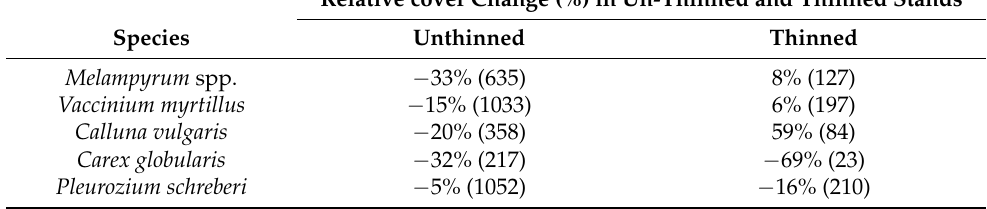
Table 4. Relative cover change for species where thinning occurred during 10 years prior to first inventory significantly ( p < 0.05) explained the observed variation. Sample size in